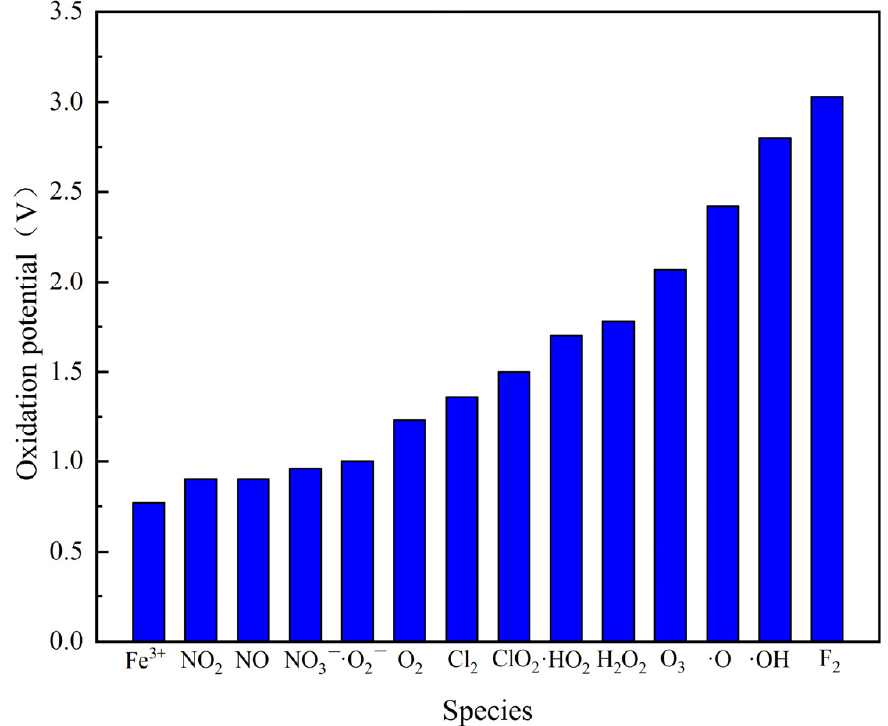
Figure 2. Comparison of oxidation potential of reactive species by non-thermal plasma.